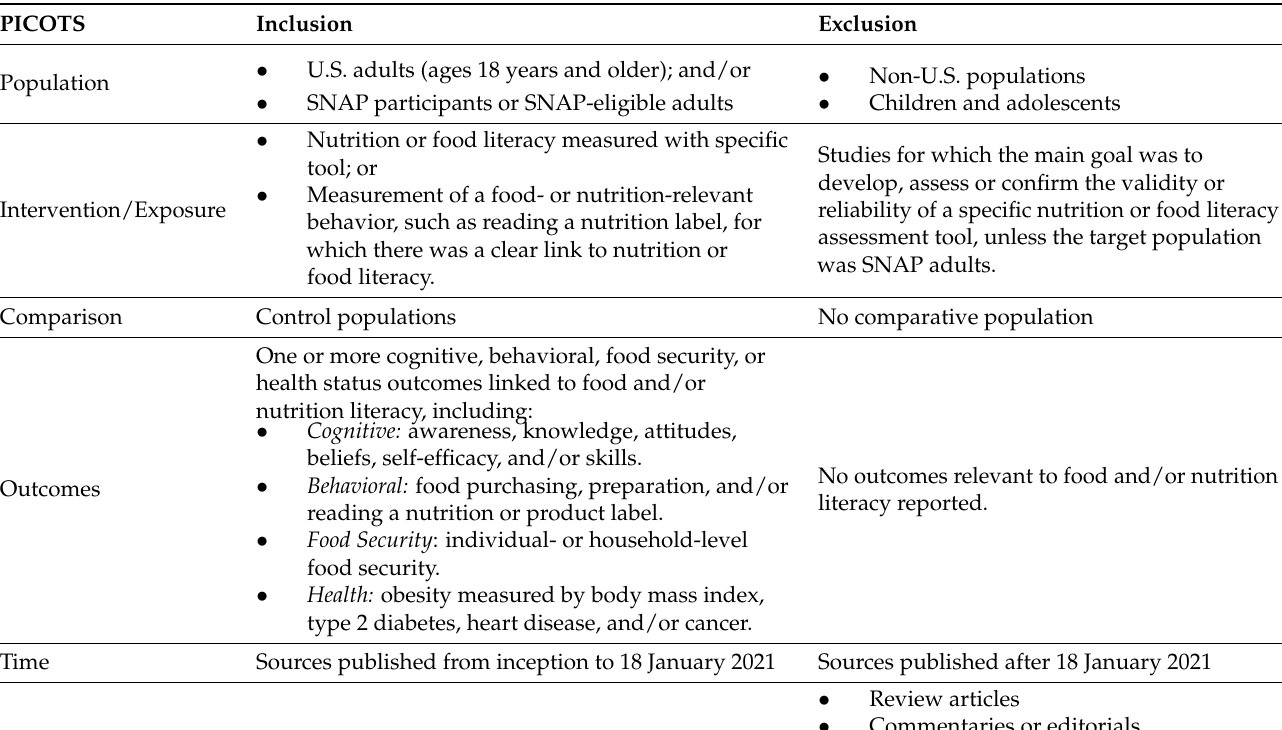
Table 1. The PICOTS framework used to identify relevant food and nutrition literacy